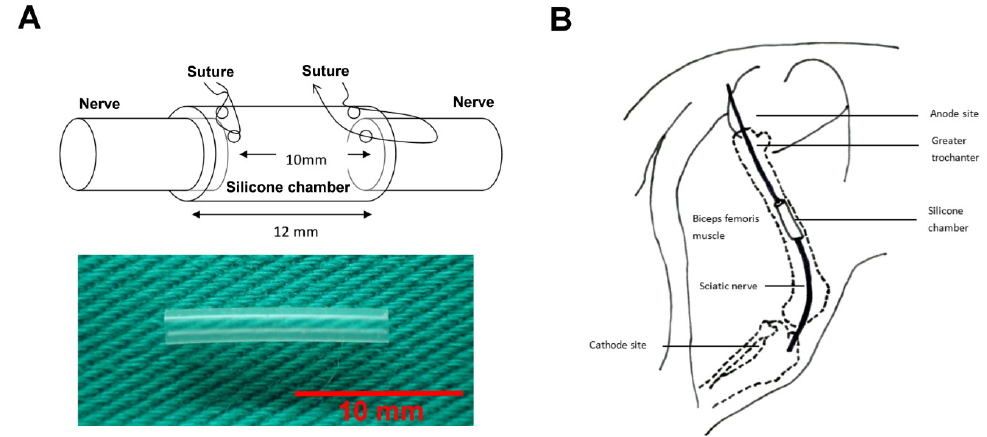
Figure 1. The diagrams to scale of ( A ) the implanted material in the animal and ( B ) electrode positions. = 10 Scale bar = 10 mm. Scale bar